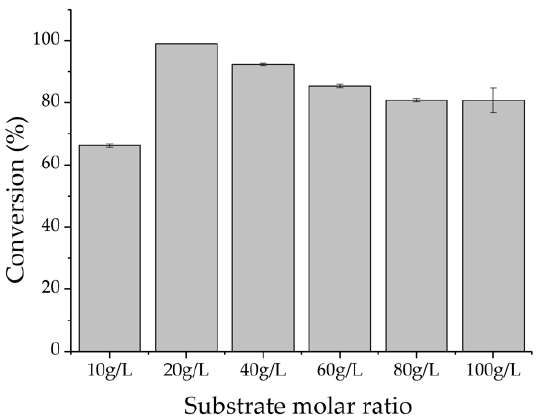
Figure 8. Optimization of the substrate molar ratio in terms of conversion with polyphosphate- dependent mannose kinase, mannose (20 g/L) and MgCl 2 (5 mM) at 30 °C at pH 8.5. As the amount of polyphosphate in the reaction increased, the conversion efficiency first increased and then decreased, and high concentrations of polyphosphate inhibited the reaction.